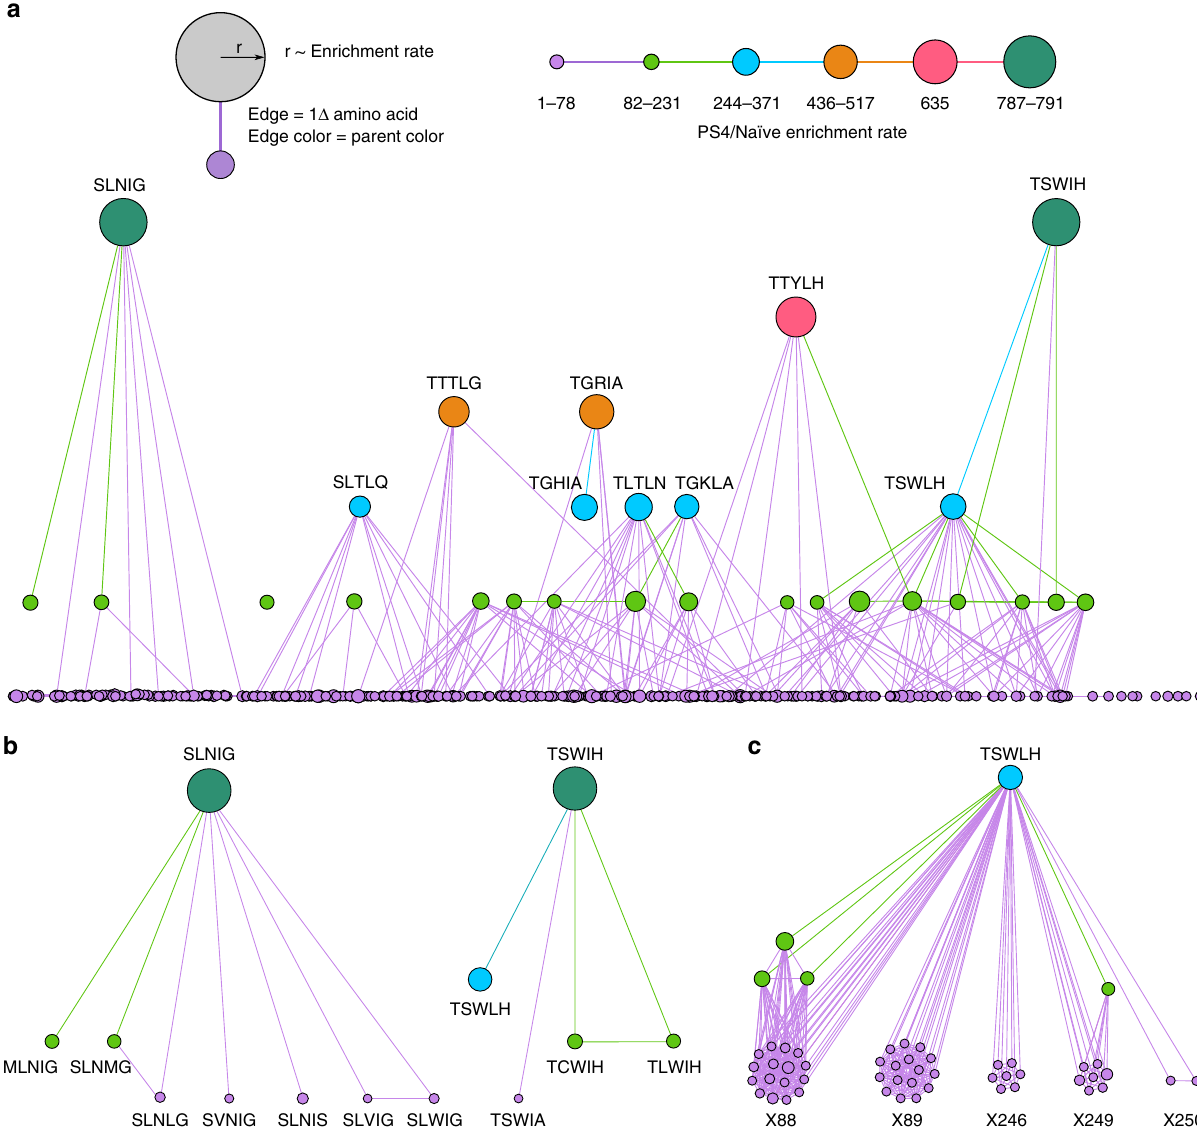
Fig. 5 Network analysis of enriched variants reveals rare paths to highly enriched variants. a A network diagram comprising Post Sort (PS) 4 variants with enrichment rate ≥ 1. Each node corresponds to a unique variant, and the node ’ s radius scales with the variant ’ s enrichment rate. Each edge represents a difference in one amino acid, and the color of each edge is the same as the variant with lower enrichment, providing a sense of the trajectory taken by Darwinian evolution, or from less fi t to more fi t. As anticipated, variants with the greatest fi tness are rare and often accessible by only few paths (edges), re fl ecting a rugged sequence – function landscape indicative of epistasis. b Isolated networks of variants SLNIG and TSWIH underscore the scarcity of paths originating from disconnected functional variants, which suggests that speci fi c combinations of residues lead to pronounced improvements in function rather than a few critical residues. This observation is indicative of epistasis, where the context (i.e., background sequence) of a protein dictates an individual residue ’ s effect on the protein ’ s phenotype. c In contrast, TSWLH is accessible by numerous paths re fl ecting a broad sequence – function landscape. Parent variants leading to TSWLH are highly interconnected as several related proteins bene fi t similarly from the same